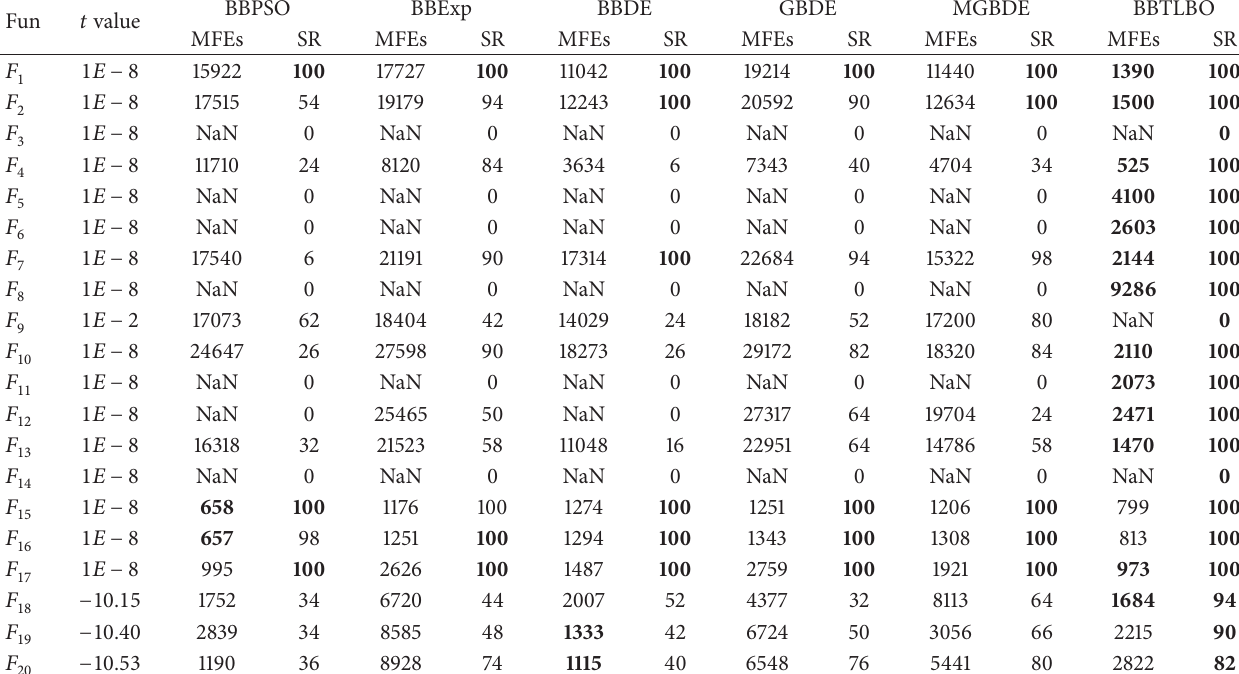
Table 4: The mean number of FEs and SR with acceptable solutions using different algorithms.